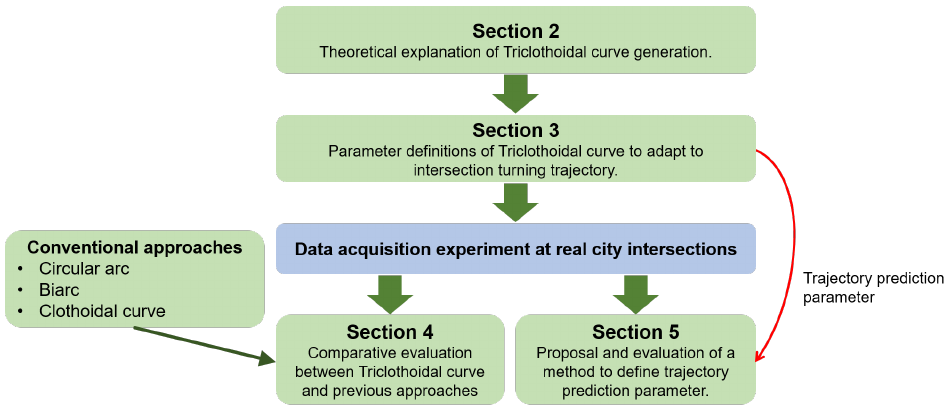
Figure 1. Structure of this